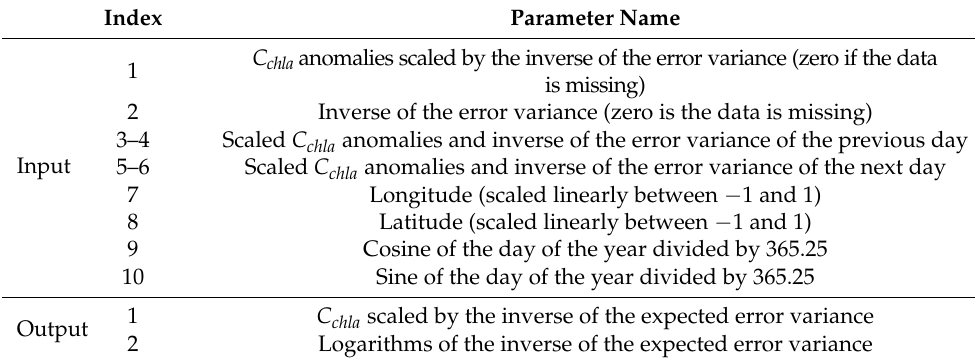
Table 1. Catalog of neural network inputs and